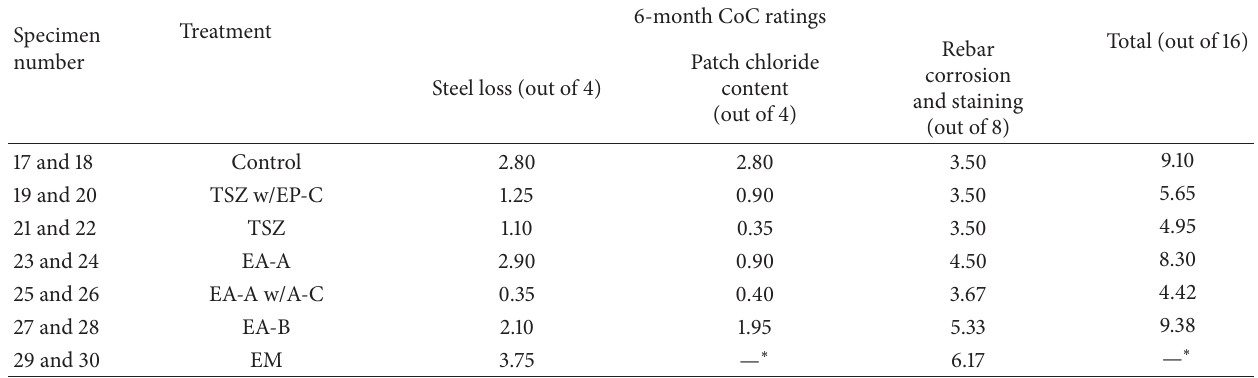
Table 9: Condition summary of CoC specimens after 6 months of